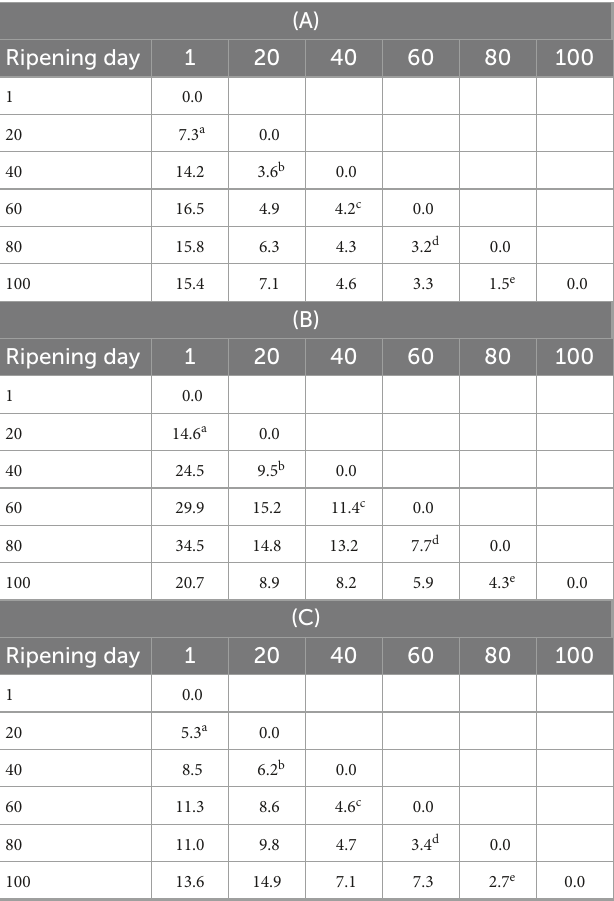
TABLE 2 Interclass distances between various cheese extracts (a: water; b: methanol; and c: ethanol) on different ripening ages, based on SIMCA model generated by the FT-IR spectral